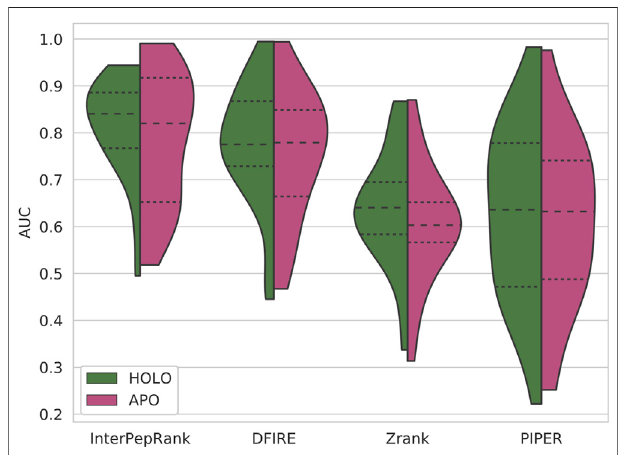
FIGURE 5 | The ROC AUC distribution of the different scoring methods on the APO/HOLO Set. The HOLO halves of the violin-plots are the AUC distributions with the receptors in their bound states during scoring. The APO halvesaretheAUCdistributionswiththereceptorsintheirexperimentally determined unbound